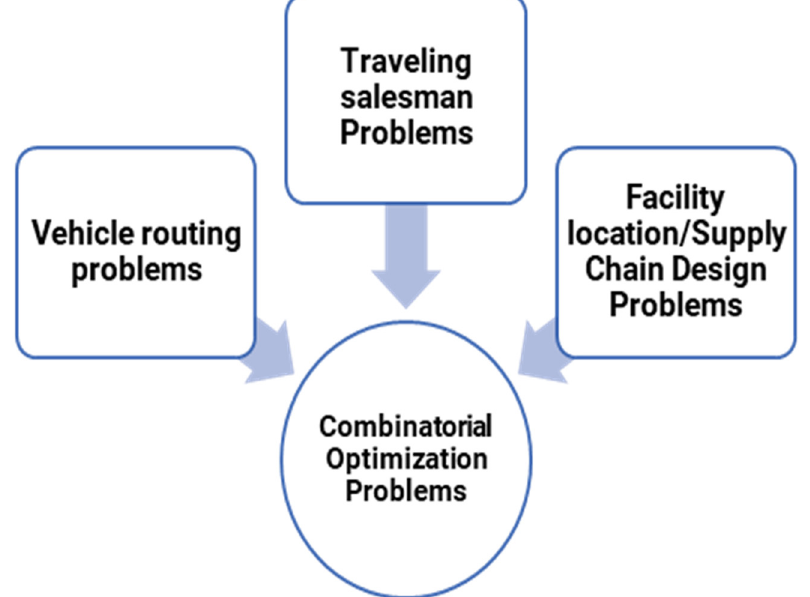
Figure 1. Selected combinatorial optimization problems.